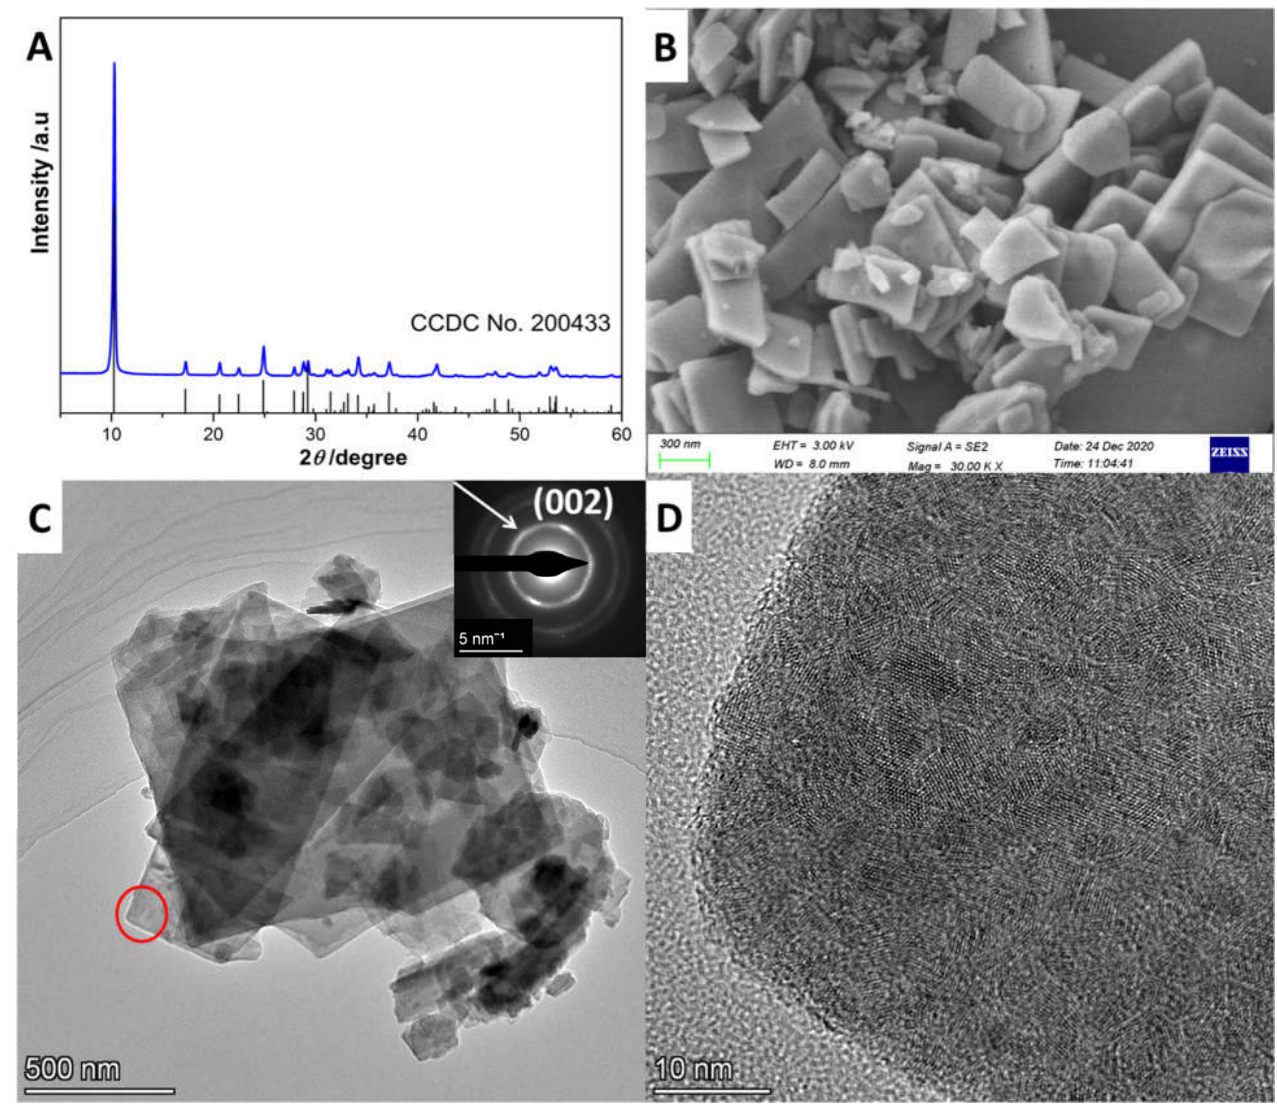
Figure 1. ( A ) XRD diffraction patterns, ( B ) SEM image, ( C ) TEM image and ( D ) HRTEM image of the as-prepared ZnS(en) 0.5 . Inset in C is the SAED image.